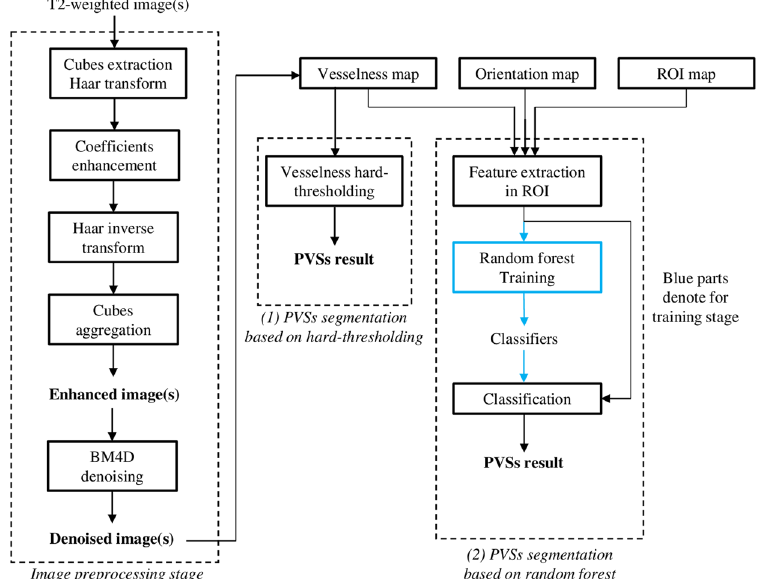
Figure 3. Framework of the proposed image enhancement (left panel) and PVS segmentation algorithm (right panel). After enhancing the image, two existing methods are used to segment the PVSs, i.e., (1) PVS segmentation based on hard-thresholding and (2) PVS segmentation based on random